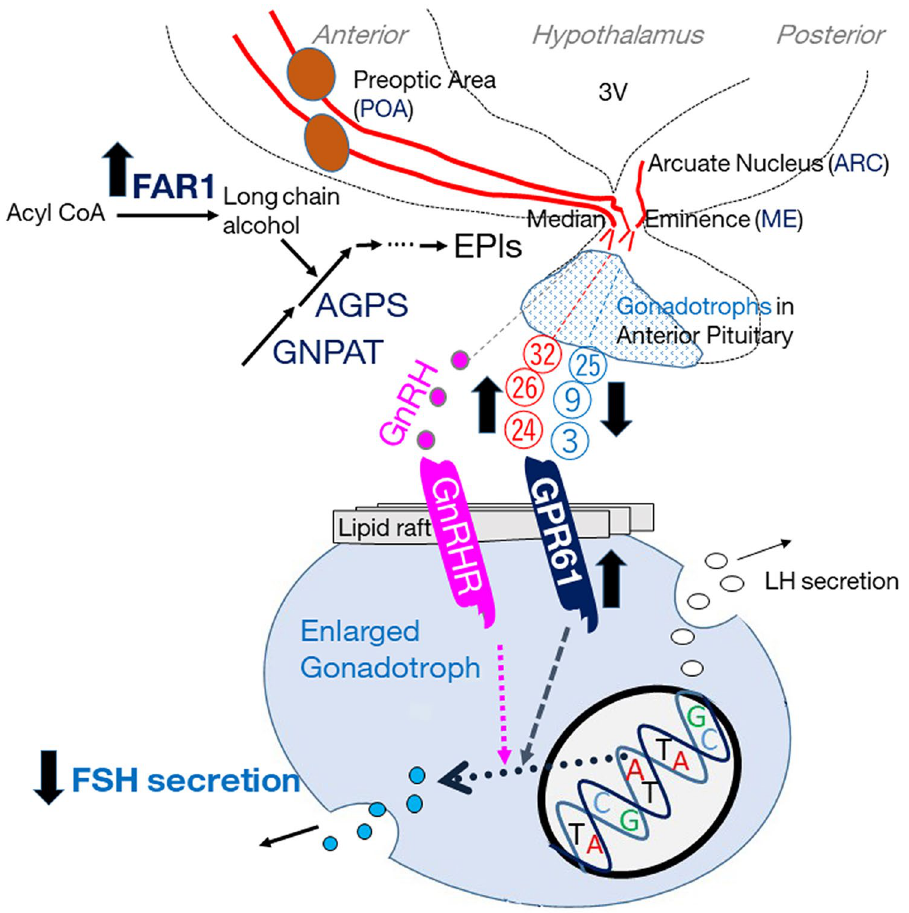
Figure 5. Graphical abstract based on the obtained data and speculation on the relationship between EPl, its biosynthesis enzymes (GNPAT, AGPS, and FAR1) in the anterior hypothalamus containing POA or the posterior hypothalamus containing ARC&ME, and gonadotroph, shown as small dots in the anterior pituitary or as enlarged circle, including the GnRHR, GPR61, and FSH and LH secretions. Red circle numbers (24, 26, and 32) indicate the peak numbers of the EPl molecular species, which were higher in old than young hypothalami. In addition, the blue circle numbers (3, 9, and 25) indicate the peak numbers of the EPl molecular species, which were lower in old than young hypothalami. The up and down bold black arrows indicate the increased or decreased levels of each molecules. We have identified 20 EPl molecular species, demonstrated that the presence of EPl in hypophyseal portal blood was just a speculation, and not evaluated the effect of each EPl molecular species. Finally, EPl produced in other tissues may possibly act on gonadotrophs. AGPS alkylglycerone phosphate synthase, FAR1 fatty acyl-CoA reductase 1, POA preoptic area, ARC&ME tissues arcuate nucleus and median eminence-containing intermediate and posterior hypothalamic tissue, GnRHR gonadotropin-releasing hormone receptor, FSH follicle-stimulating hormone, LH luteinising